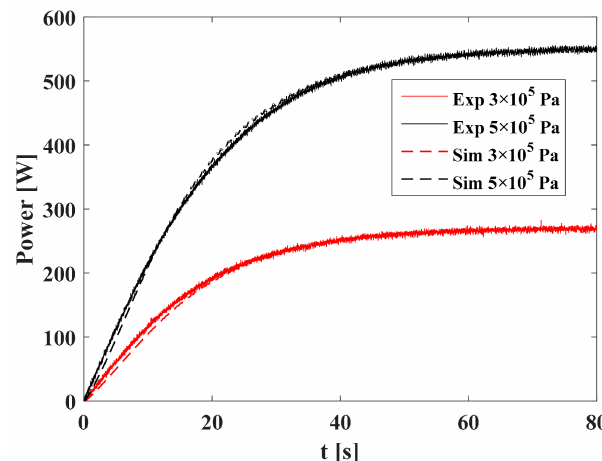
Figure 9. Air power output from the system.